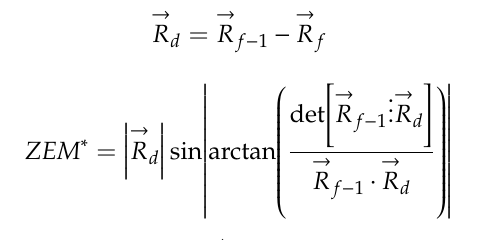
Figure 2. Diagram of Zero-Effort-Miss (ZEM)* definition.